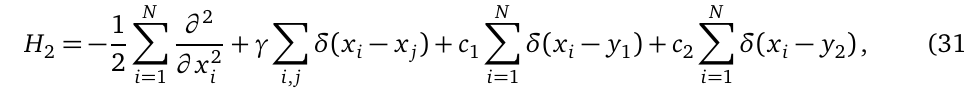
= 0, and another one with the interaction strength c 1